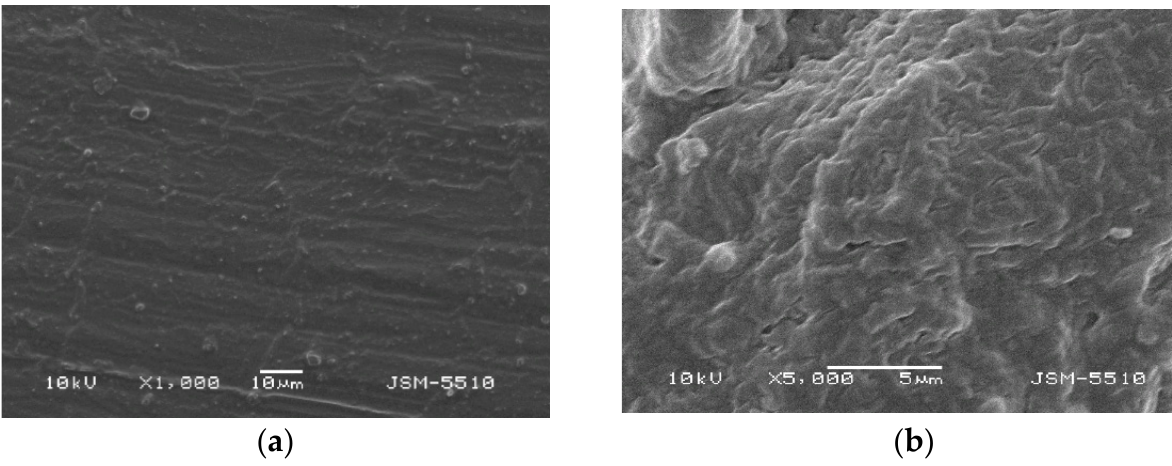
Figure 6. ( a ) TS under magnification ×1000. ( b ) TS under magnification ×5000.